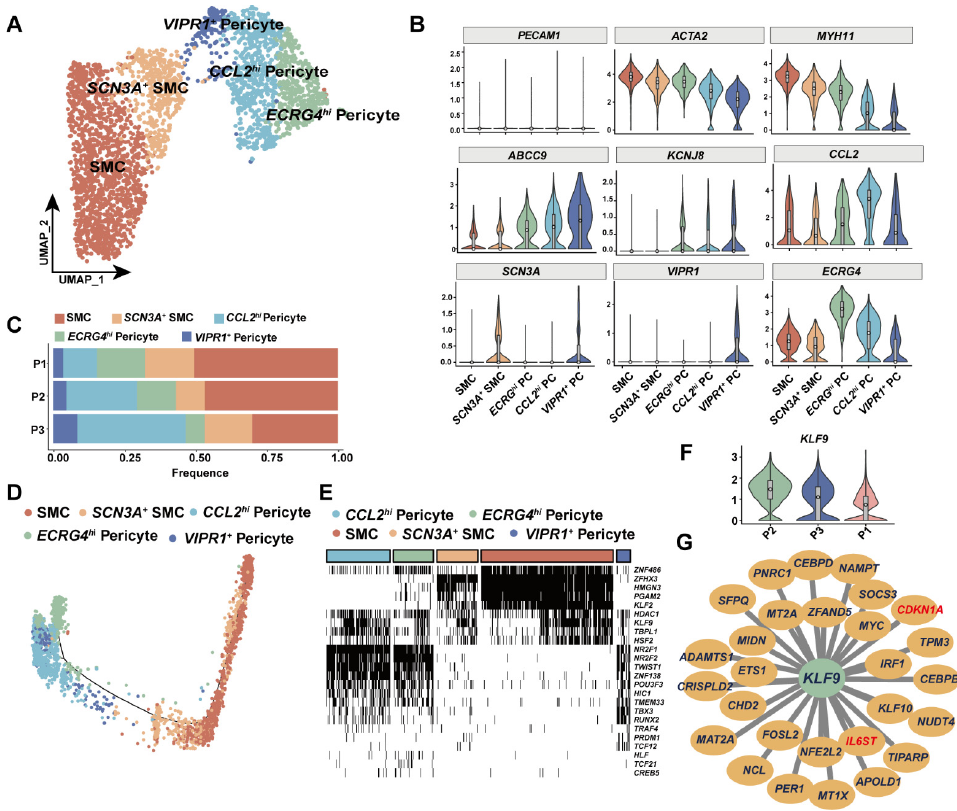
Figure 4. Single-cell analysis of smooth muscle cells and pericytes. ( A ) The UMAP plot of smooth muscle cell (SMC) and pericyte subsets. ( B ) Violin plot of SMC and pericyte conventional markers (upper row) and unique markers identified in our data (bottom row). ( C ) Mural cell composition in each patient is shown. ( D ) Pseudo-time analysis reveals that SMC and pericytes were